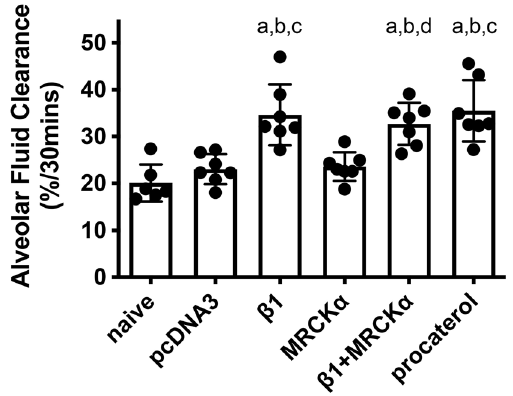
Figure 11. Electroporation mediated gene transfer of MRCKα has no effect on rates of alveolar fluid clearance. Plasmids (100 µg each) expressing either no insert (pcDNA3), the β1 subunit of the Na + ,K + -ATPase (β1), MRCKα, or β1 and MRCKα were delivered in 50 µl to the lungs of C75B6 mice (n = 6–7) by aspiration followed immediately by electroporation (8 pulses of 10 ms duration each and 200 V/cm). Naïve mice received no DNA. Two days later, alveolar fluid clearance was measured in living mice and calculated based on the change in concentration of Evans Blue Dye-labeled albumin in an isosmolar (324 mOsm) instillate placed into the alveolar space and mechanically ventilated over a 30 min period. Procaterol (10 −8 mol/L) was administered in the instillate and used as the positive control in a set of naïve mice. Rates of alveolar fluid clearance are shown as mean ± SEM. All experiments were carried out three times and a representative experiment is shown. One-way ANOVA with post-hoc Tukey’s multiple comparisons was used for statistical analysis; a, p < 0.01 compared to naïve; b, p < 0.001 compared to pcDNA3; c, p < 0.01 compared to MRCKα; d, p < 0.05 compared to